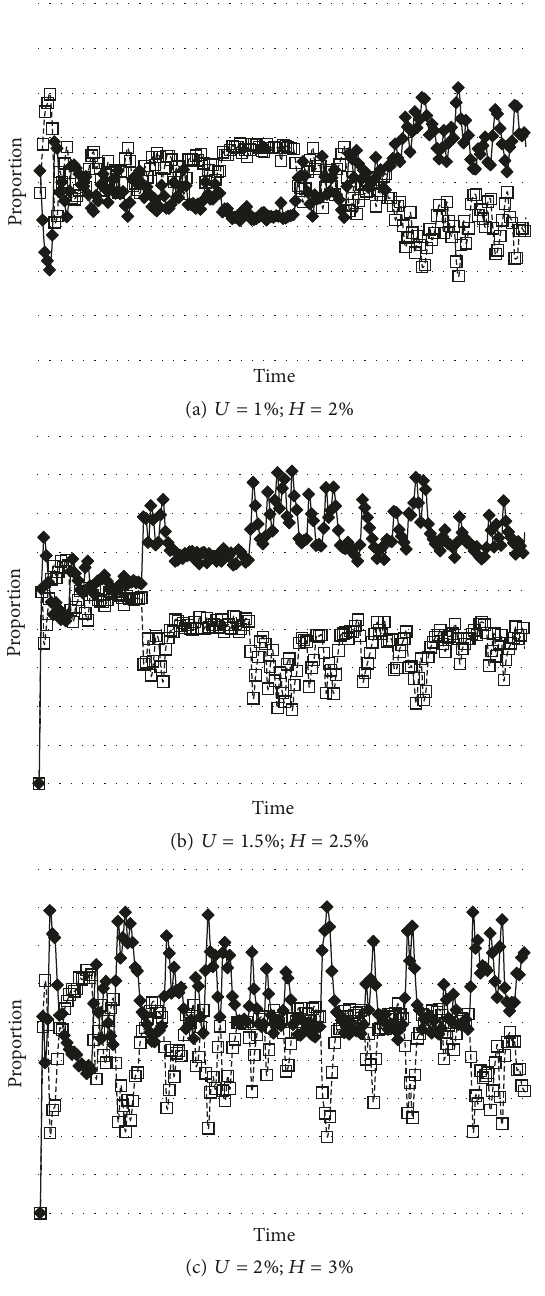
Figure5:Theevolutionarytrendoftheproducers’strategyselection in model II.